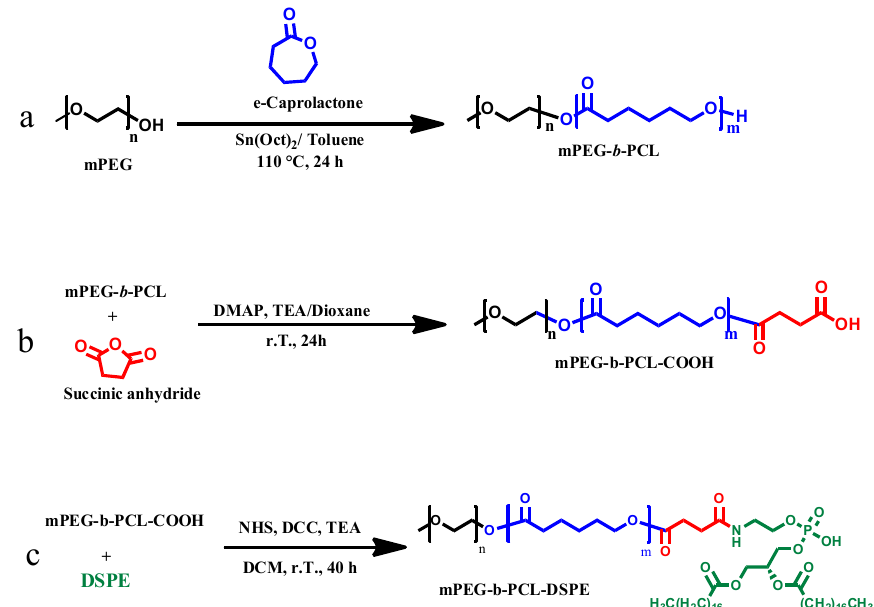
Figure 1. Spectral characterisation of a representative DSPE-terminated copolymer (PP3-DSPE). ( a ) XPS and ( b ) 1 NMR spectra.